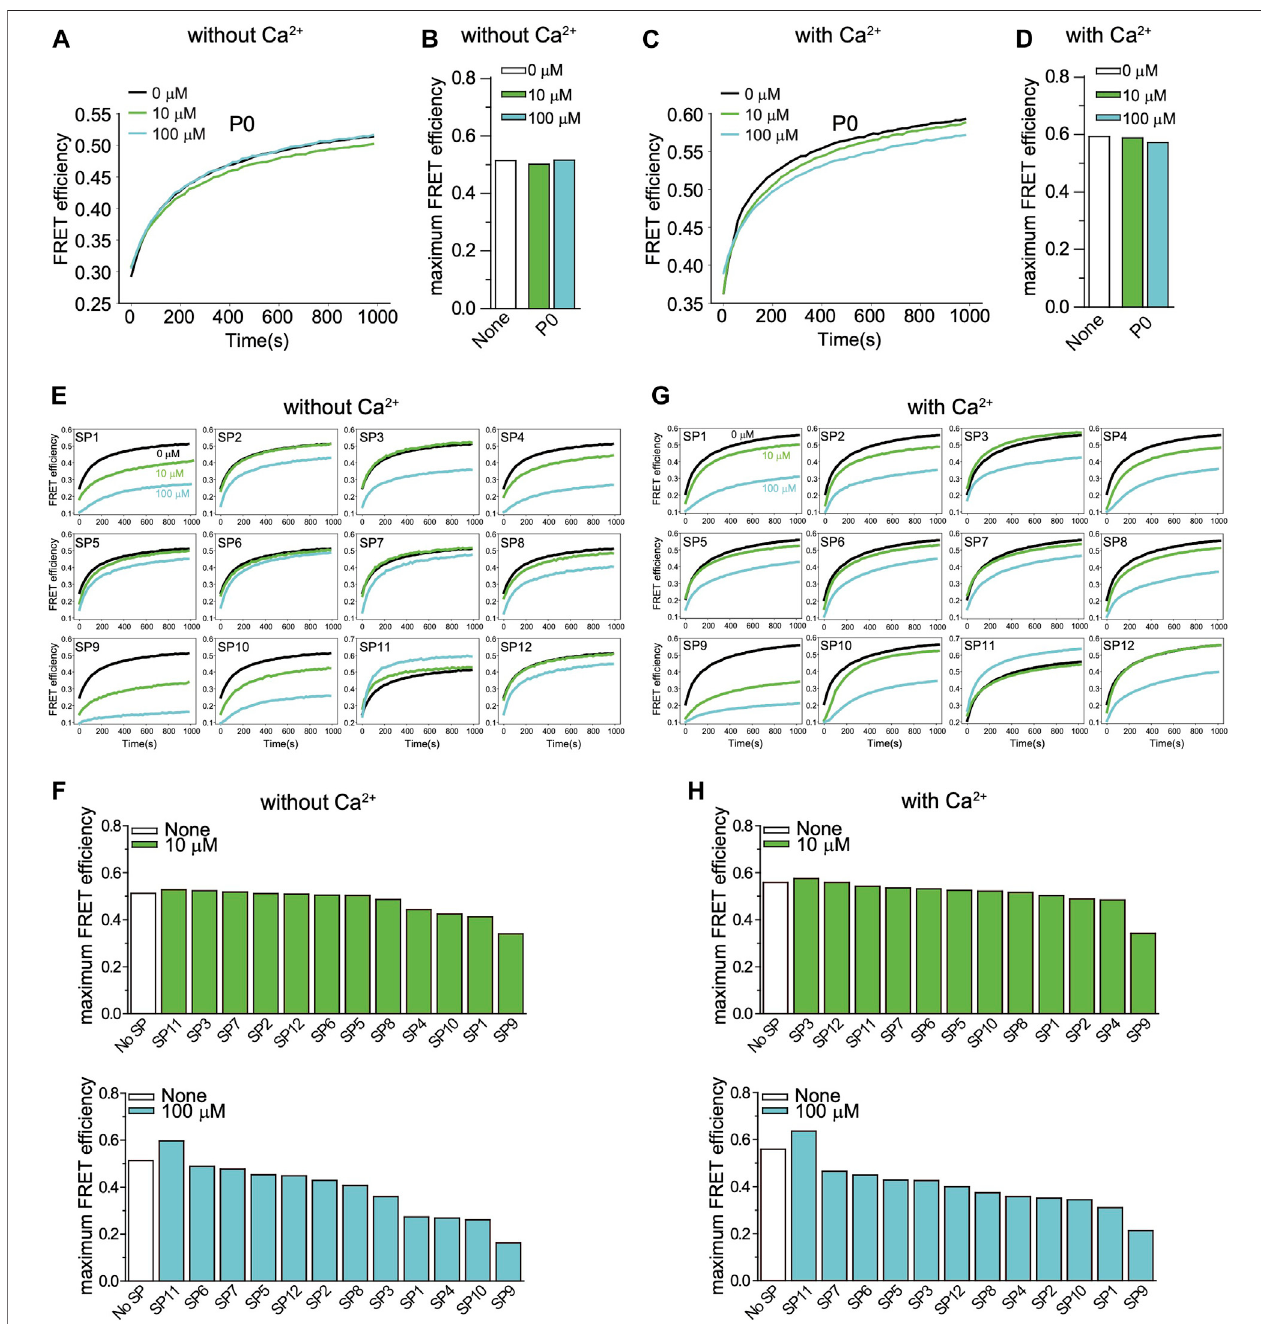
FIGURE2| EffectofstapledpeptidesinensemblelipidmixingassayswithneuronalSNAREsandSyt1. (A) Thenon-stapledpeptideP0haslittleeffectonCa 2+ -independent ensemble lipid mixing measurements of vesicle-vesicle fusion with SV and PM vesicles (Methods). The two groups of vesicles are mixed at the same molar ratio with a fi nal lipid concentrationof0.1 mM.ThetimetracesshowFRETef fi ciencyuponmixingdye-labeledneuronalPM-andSV-vesicles(Methods).Theblacklineisacontrolwithoutpeptide.The greenandbluelinesindicatethelipidmixingexperimentswith10and100 µMP0,respectively. (B) CorrespondingmaximumFRETef fi ciencywithintheobservationperiodof 1,000 s. (C) P0haslittleeffectonCa 2+ -triggeredensemblelipidmixingmeasurementsofvesicle-vesiclefusion.Thetwogroupsofvesiclesaremixedatthesamemolarratiowitha fi nal lipid concentration of 0.1 mM. The time traces show FRET ef fi ciency upon mixing dye-labeled neuronal PM- and SV-vesicles (Methods). The black line is a control without peptide. The green and blue lines represent the reaction with 10 and 100 µM P0, respectively. (D) Corresponding maximum FRET ef fi ciency within the observation period of 1,000 s. (E) EffectofstapledpeptidesinabsenceofCa 2+ .Thetwogroupsofvesicles(SVandPM)weremixedatthesamemolarratiowitha fi nallipidconcentrationof0.1 mM.The timetracesshowFRETef fi ciencyuponmixingneuronaldye-labeledPM-andSV-vesicles(Methods). (F) CorrespondingmaximumFRETef fi ciencywithintheobservationperiodof 1,000 s. (G) Effect of stapled peptides in the presence of Ca 2+ . The two groups of vesicles (SV and PM) were mixed at the same molar ratio with a fi nal lipid concentration of 0.1 mM.ThetimetracesshowFRETef fi ciencyuponmixingneuronalPM-andSV-vesicles. (H) CorrespondingmaximumFRETef fi ciencywithintheobservationperiodof1,000 s.